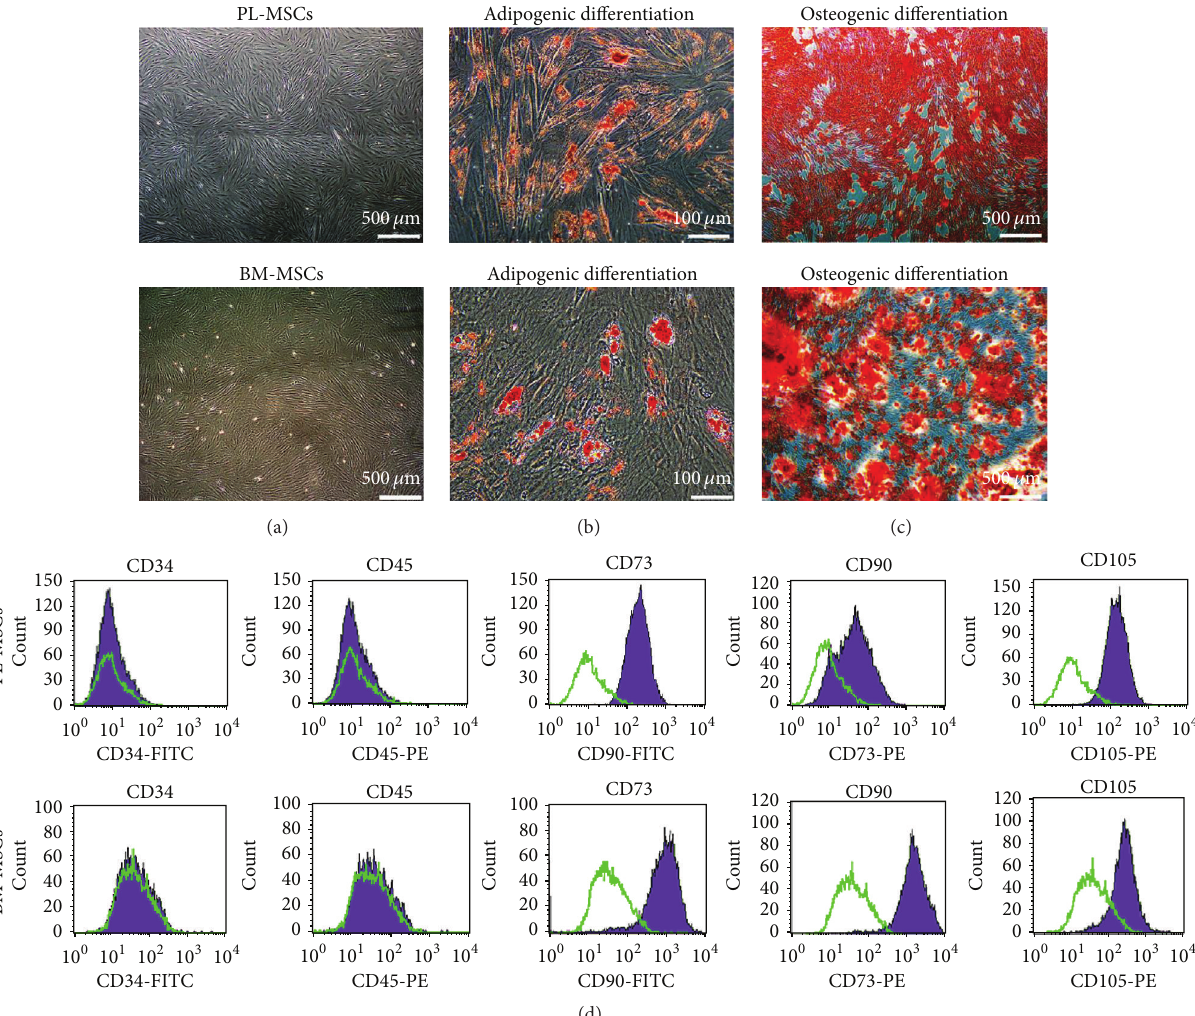
Figure 1: Characteristics of PL-MSCs and BM-MSCs. (a) Fibroblast-like morphology of PL-MSCs and BM-MSCs (scale bar = 500 𝜇 m). (b) Adipogenic differentiation of PL-MSCs and BM-MSCs as demonstrated by Oil Red O staining (scale bar = 100 𝜇 m). (c) Osteogenic differentiation of PL-MSCs and BM-MSCs as demonstrated by Alizarin Red S staining (scale bar = 500 𝜇 m). (d) Immunophenotype of PL- MSCs and BM-MSCs as determined by flow